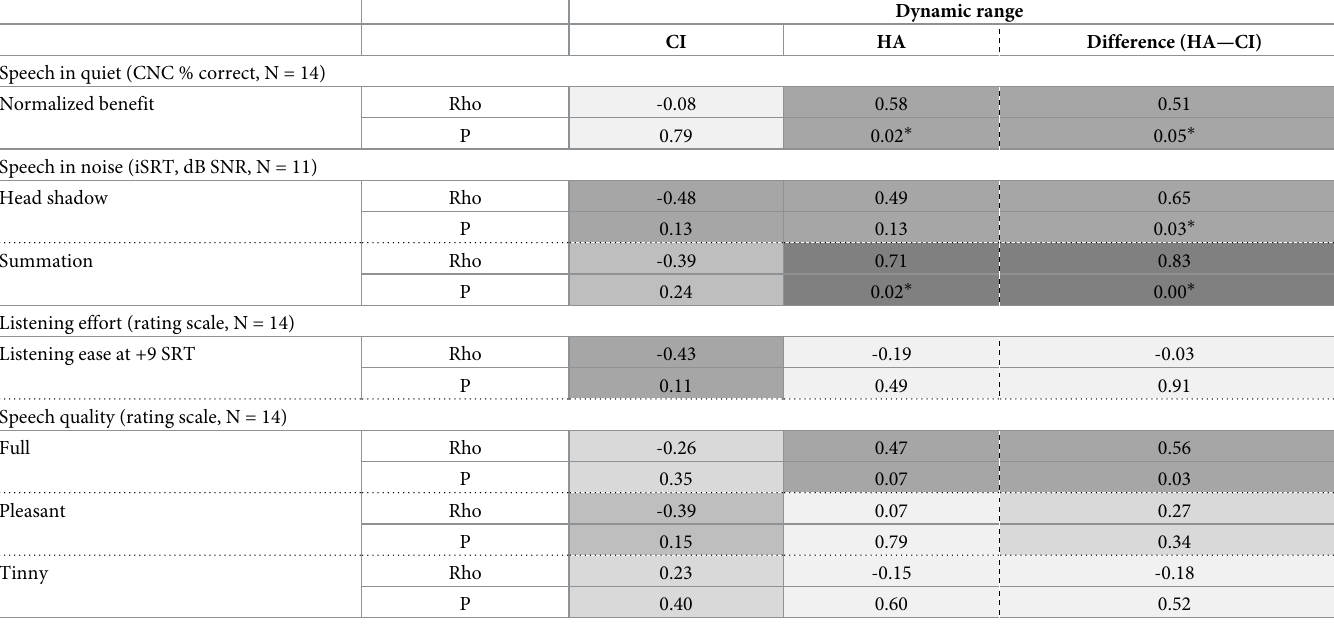
Table 5. Correlations between dynamic range (difference between stimulus intensity levels (dB HL) at threshold (T5CU) and at the first position where maximum CU was reached, averaged across frequencies) and bimodal benefit on various outcomes.